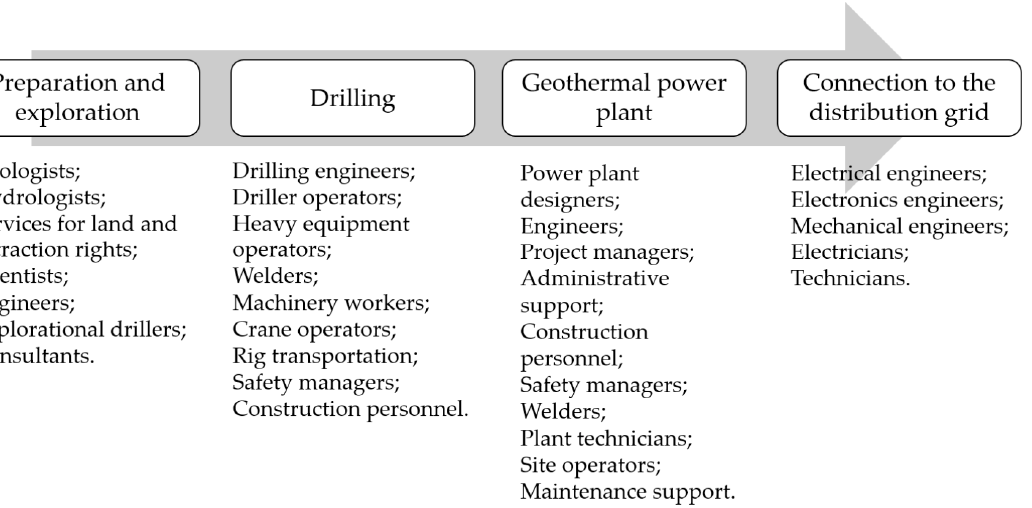
Figure 9. Example of personnel required for each phase of the geothermal plant development.